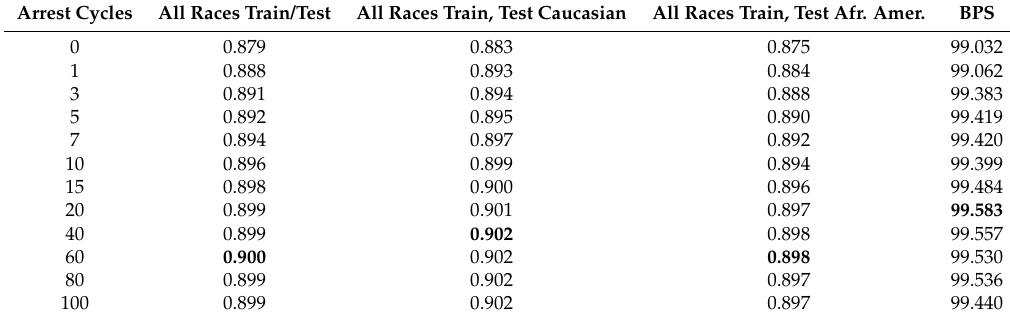
Table 1. Average accuracy.